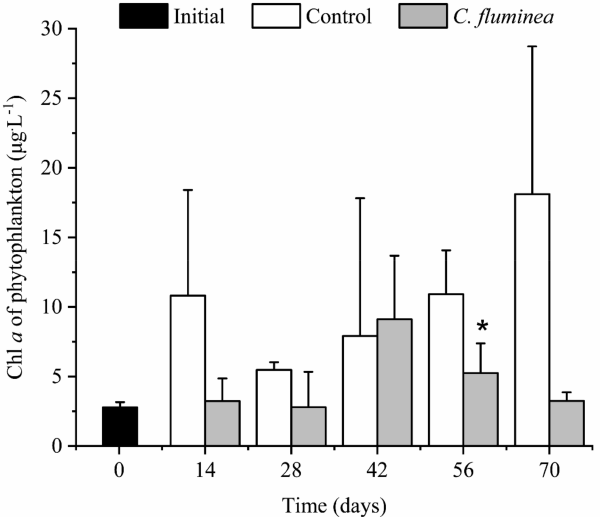
Figure 5. Chl a of phytoplankton (mean ± SD) in different treatments over time. Asterisk indicates significant differences between the treatments and controls ( p <